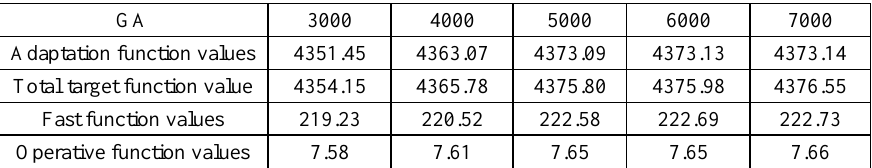
Table 1 . M 08 genetic algorithm.